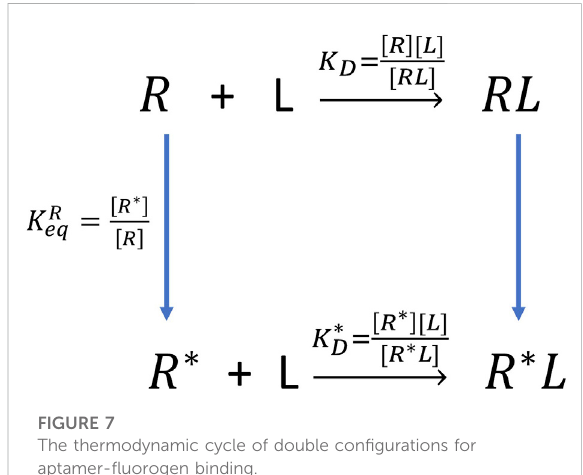
FIGURE 7 The thermodynamic cycle of double con fi gurations for aptamer- fl uorogen